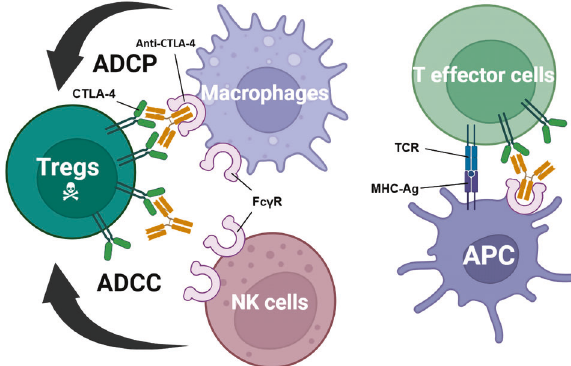
Fig. 5 Roles of Fc γ receptors in anti-CTLA-4 function. Selective deletion of Tregs in the tumor microenvironment results in tumor immunity (left). Expressing higher levels of CTLA-4 than effector T cells, intratumoral Tregs are selectively depleted through ADCP by macrophages and/or ADCC by NK cells. In T-effector cells, T-cell activity is enhanced by the recognition of MHC-Ag by the TCR in the presence of an anti-CTLA-4 antibody that had co-engaged with Fc γ R on APCs (right). ADCC antibody-dependent cellular cytotoxicity, antigen peptide complexes major histocompatibility complex- antigen peptide complexes, NK cells natural killer cells, TCR T-cell